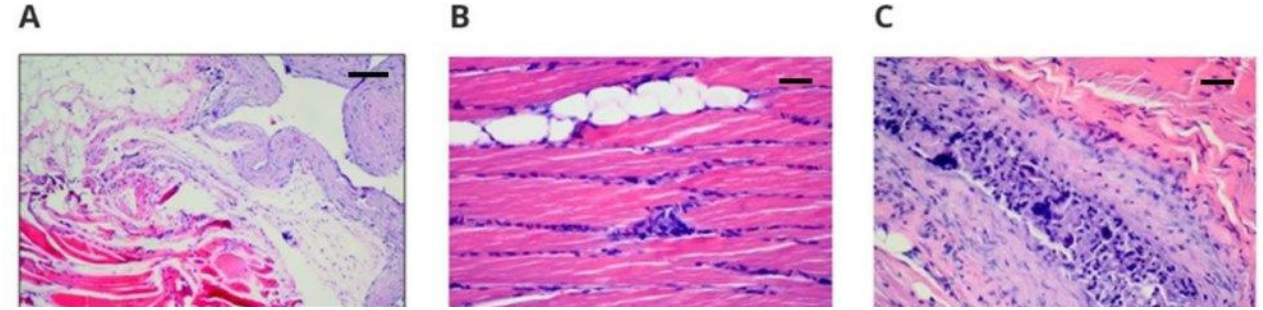
Figure 2. Microscopically assessed image of the site of implantation and the surrounding transverse striated muscles taken from animals with implants, 50× magnification: ( A ) margin, 50× magnifica- tion hematoxylin–eosin staining (scale bar 200 µm). Visible fibrotic connective tissue capsule with a slight inflammatory path; ( B ) transverse striated muscle 100% × magnification (scale bar 100 µm), hematoxylin–eosin staining visibly clear and significant inflammation with histiocyte foci and his- tiophagocytosis; ( C ) margin, 50× magnification (scale bar 100 µm), hematoxylin–eosin staining, vis- ible resorptive reaction containing large dark multinucleated cells inside the connective tissue scar.